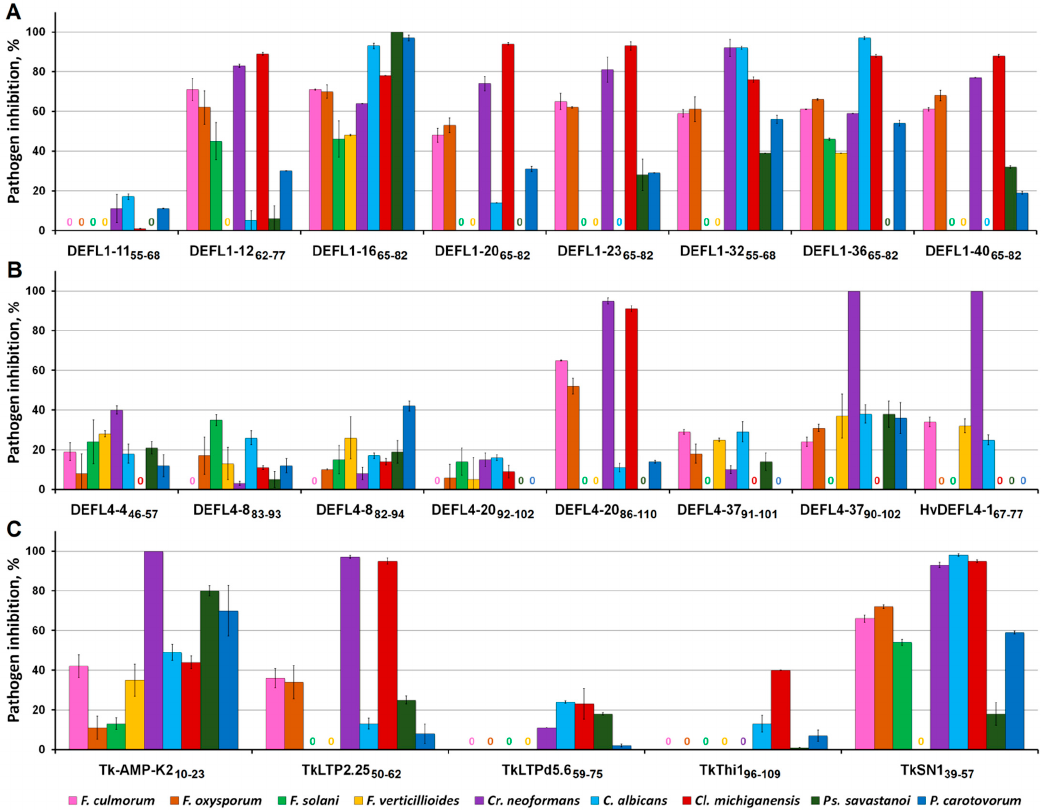
Figure 3. Growth inhibition of pathogens in the presence of 300 μ M of synthetic peptides: ( A ) 8-Cys DEFL-derived peptides; ( B ) 4-Cys DEFL-derived peptides; ( C ) peptides derived from the knottin, nsLTPs, thionin and snakin. Bars represent the mean ± SD of growth compared to control (pathogen growth in the absence of peptide).